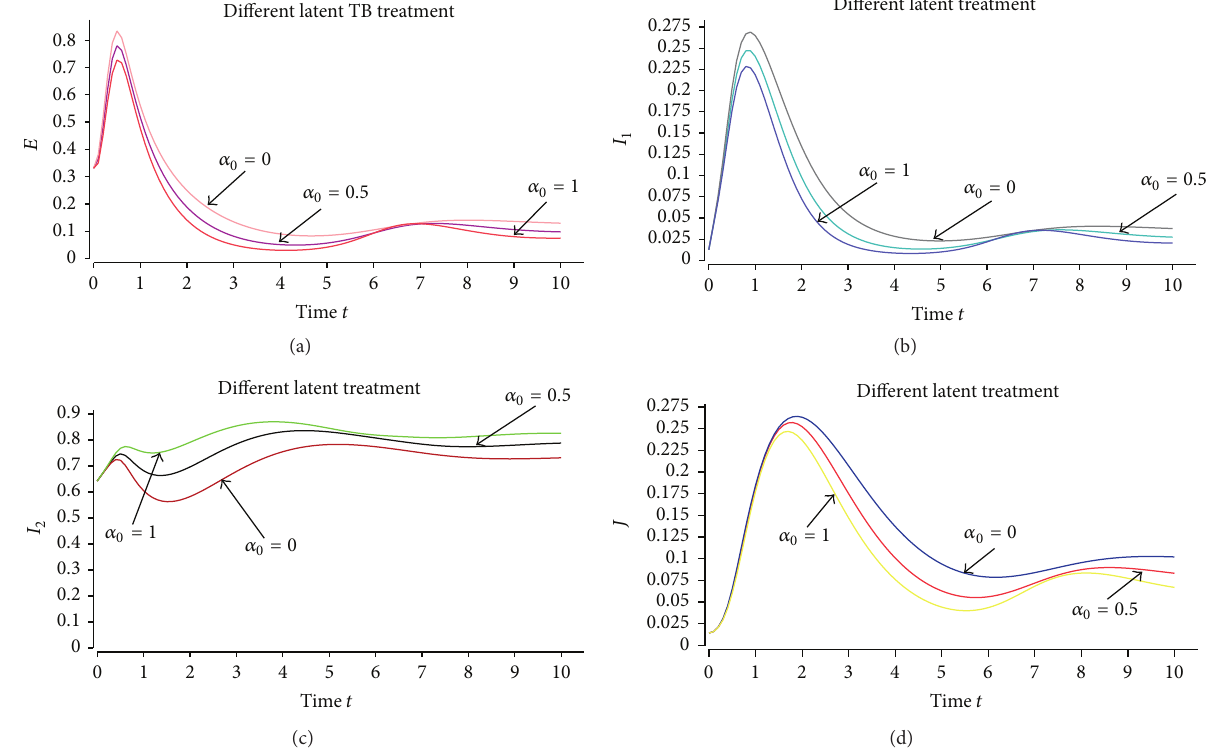
Figure 5: We take different latent TB treatments while we take no treatment of HAART and active TB.